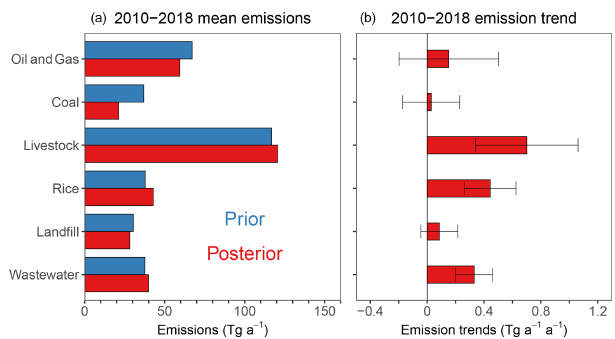
Figure 15. The 2010–2018 global methane anthropogenic emis- sions and emission trends partitioned by individual sectors. Poste- rior estimates are from our inversion of GOSAT data. Prior esti- mates for anthropogenic emission trends are zero. Error bars in (b) show posterior error standard deviations for emission trends. Poste- rior error standard deviations for mean emissions are small and are thus not shown in (a)